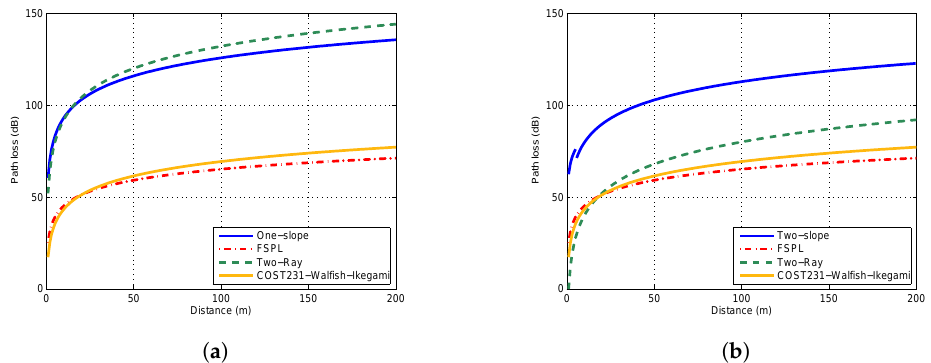
Figure 6. Comparison of path loss models in the flat concrete road scenario: ( a ) H t = H r = 5 cm; and ( b ) H t = H r = 1